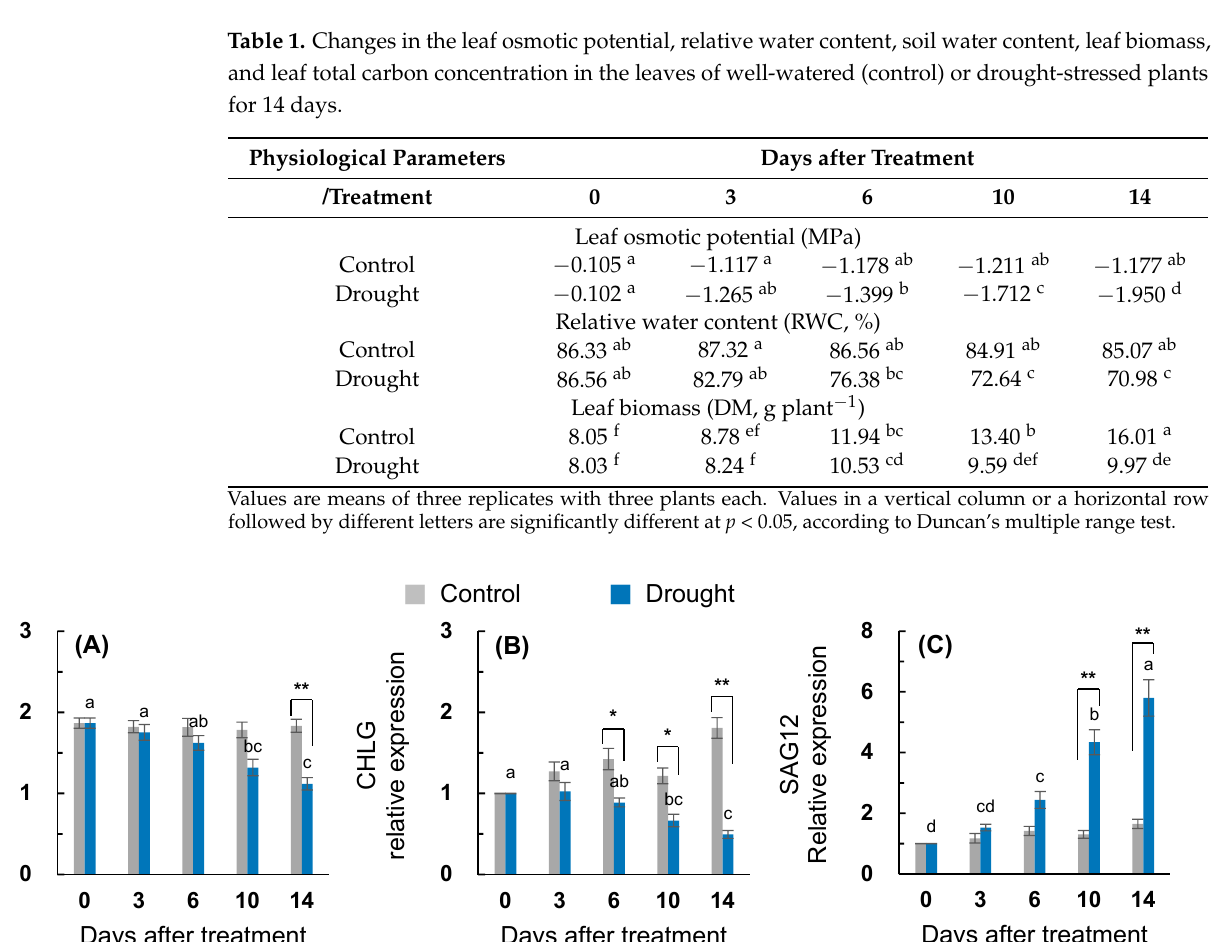
Figure 1. Changes in the ( A ) chlorophyll content, ( B ) chlorophyll synthesis gene CHLG , and ( C ) senescence-associated gene 12 ( SAG12 ) in the leaves of the well-watered control or drought-stressed plants during 14 days of treatment. Data are presented as mean ± standard error (SE) for n = 4. Bars labeled with different letters in the drought-stressed plants are significantly different at p < 0.05, according to Duncan’s multiple range test. Asterisks denote a statistical difference between the drought treatment and control: * p < 0.05, ** p < 0.01. Table 2. Changes in the endogenous level of abscisic acid (ABA), salicylic acid (SA), and their ratio in the leaves of well-watered (control) or drought-stressed plants during 14 days of treatment. Days after Treatment 0 Treatment Control Drought Control Drought Control Drought Control Drought Control Drought